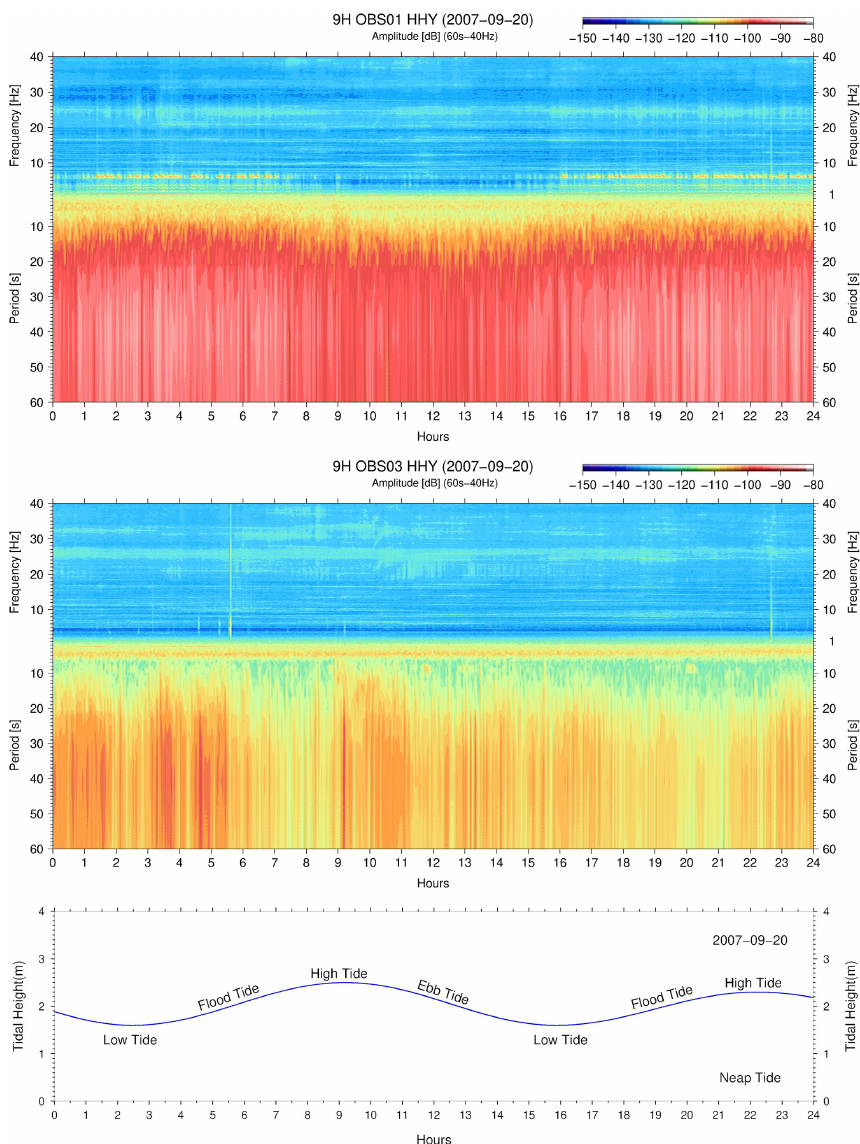
Figure 7. Neap tide in quarter moon – 9H OBS01 and 9H OBS03 spectrograms during the neap tide period (20 September 2007). The permanent low-frequency flow dominates over the tide flow. The tidal range in neap tide was 0.7m (measured in